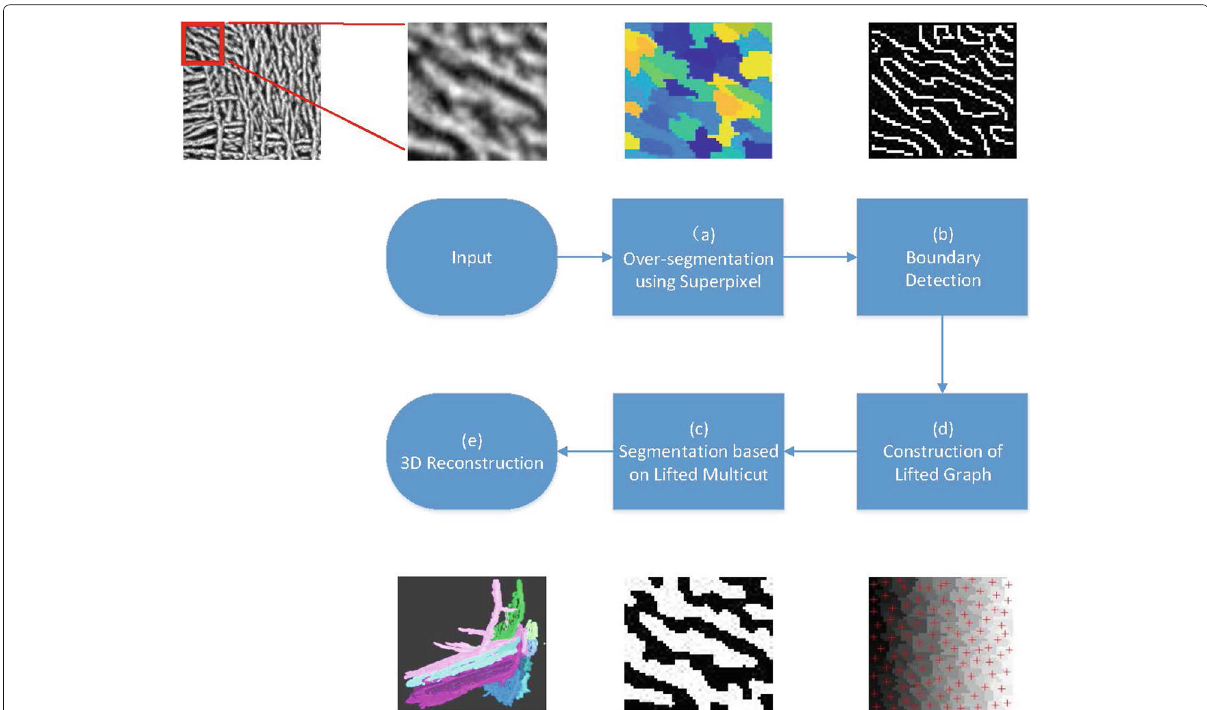
Fig. 2 Illustration of the pipeline of the lifted multicut segmentation and